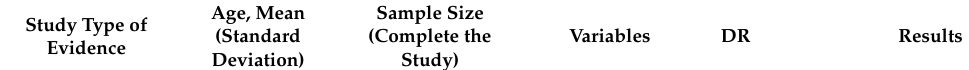
Table 1. Main characteristics of the studies included in the review.